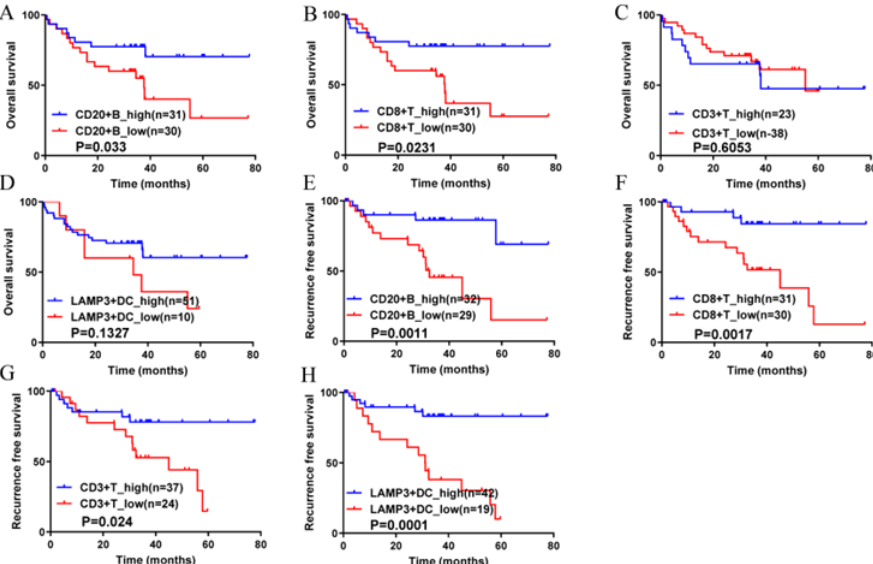
Figure 4. Xijing Hospital data, effects of CD20+ B cells, CD3+ T cells, CD8+ T cells and LAMP3+ DCs in TLSs on overall survival and recurrence-free survival in patients with hepatocellular carcinoma. ( A ) The higher the expression of CD20+B cells, the better the OS of HCC patients; ( B ) The higher expression of CD8+ T cells, the better OS of HCC patients; ( C ) CD3+ T cells have no effect on OS of HCC patients; ( D ) The higher expression of LAMP3+DC cells, the better OS of HCC patients; ( E – H ) The higher the expression of CD20+B cells, CD8+ T cells, CD3+ T cells and LAMP3+DC cells, the better the RFS of HCC patients. CD20+ B cells, CD3+ T cells, CD8+ T cells and LAMP3+ DCs were divided into a high expression group and a low expression group according to the cut-off value.